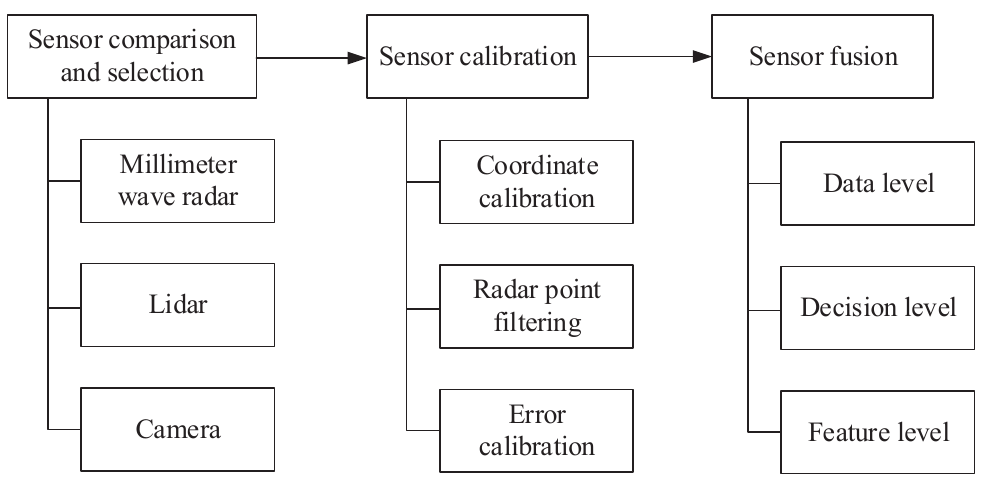
Figure 1. Process of mmWave radar and vision